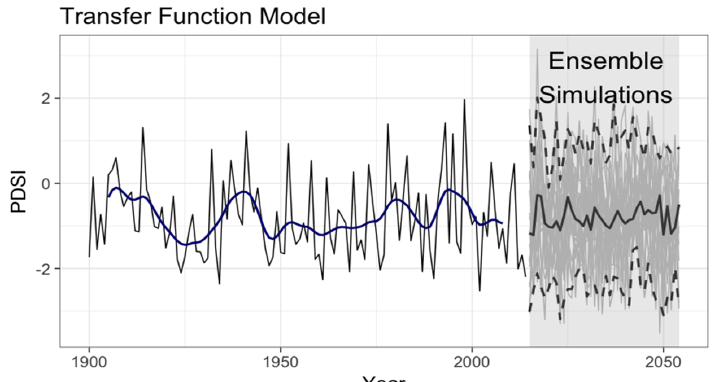
Figure 13. Observed PDSI time series (black line) with the simulation plume (grey lines) for the period 2015–2054, including the filtered observed series (navy-blue line), the median of the simulated values (thick grey line) and the 2.5% (bottom dashed line) and 97.5% quantile (top dashed line) of the simulated values.